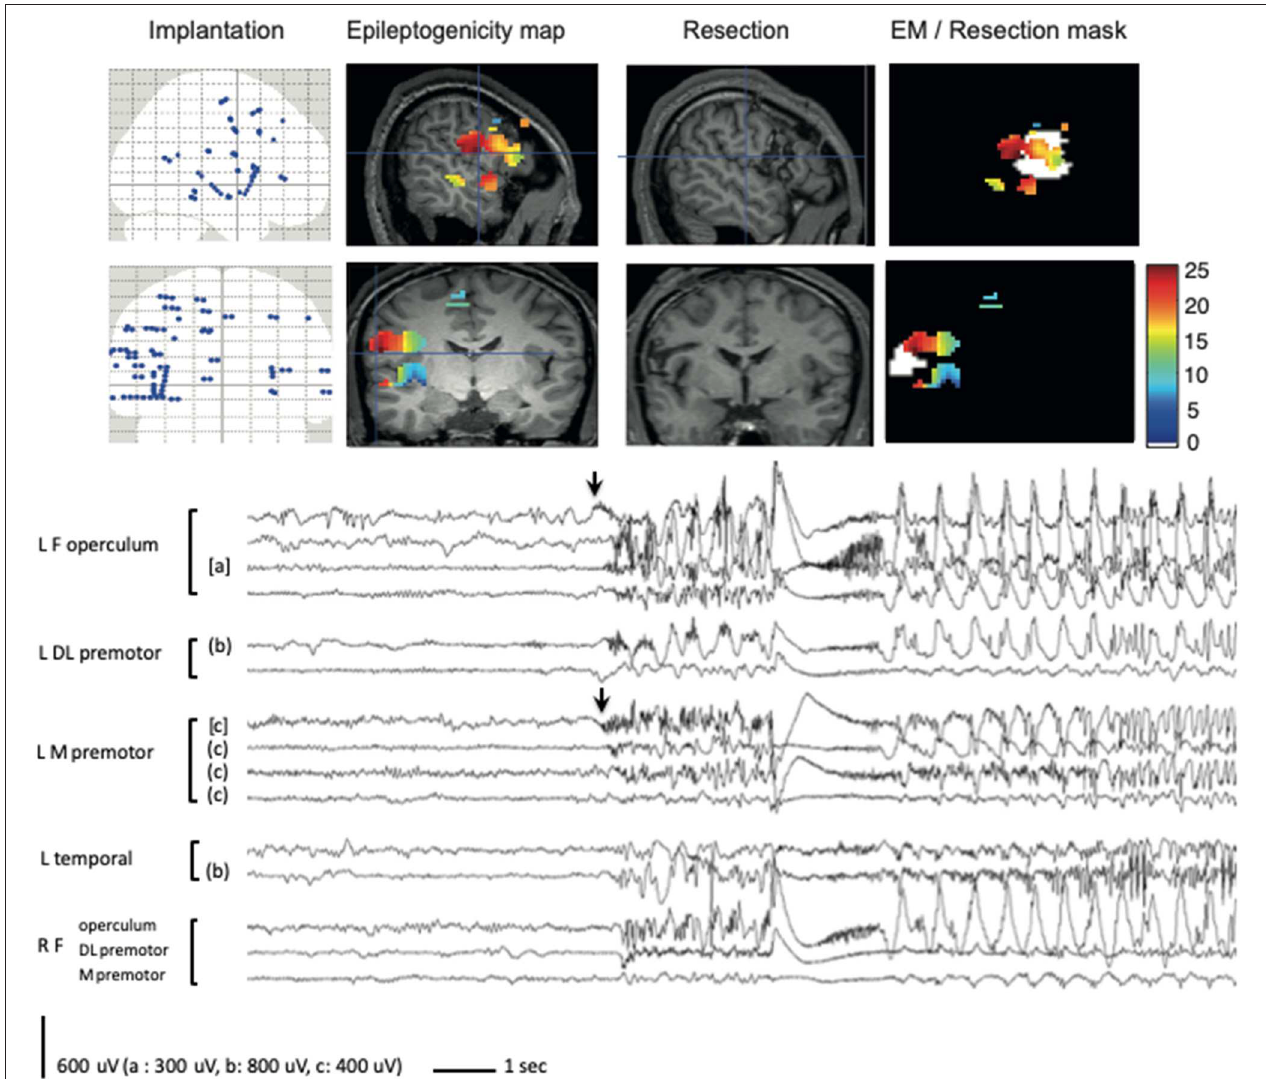
FIGURE 2 | EM method applied to a frontal epilepsy case (#6). A bilateral premotor and opercular implantation was performed, predominating on the left. The fourth seizure recorded is shown, demonstrating a widely extended mesio-lateral network at seizure onset, involving predominantly the left frontal operculum but also the left mesial premotor cortex (arrows). EM applied to the same seizure demonstrated similar significant activation of FA, but enhanced the major involvement (in red) of the frontal operculum. Resection was mainly targeted over the frontal operculum but proved incomplete because of a weak participation of the patient during awake surgery, which did not allow to correctly evaluate language areas. FASTectomy ratio was low (17.7%) and patient was not improved after surgery. The colorbar indicates the epileptogenicity values. Resection mask is in white. R, right; L, left; F, frontal; DL, dorsolateral; M,